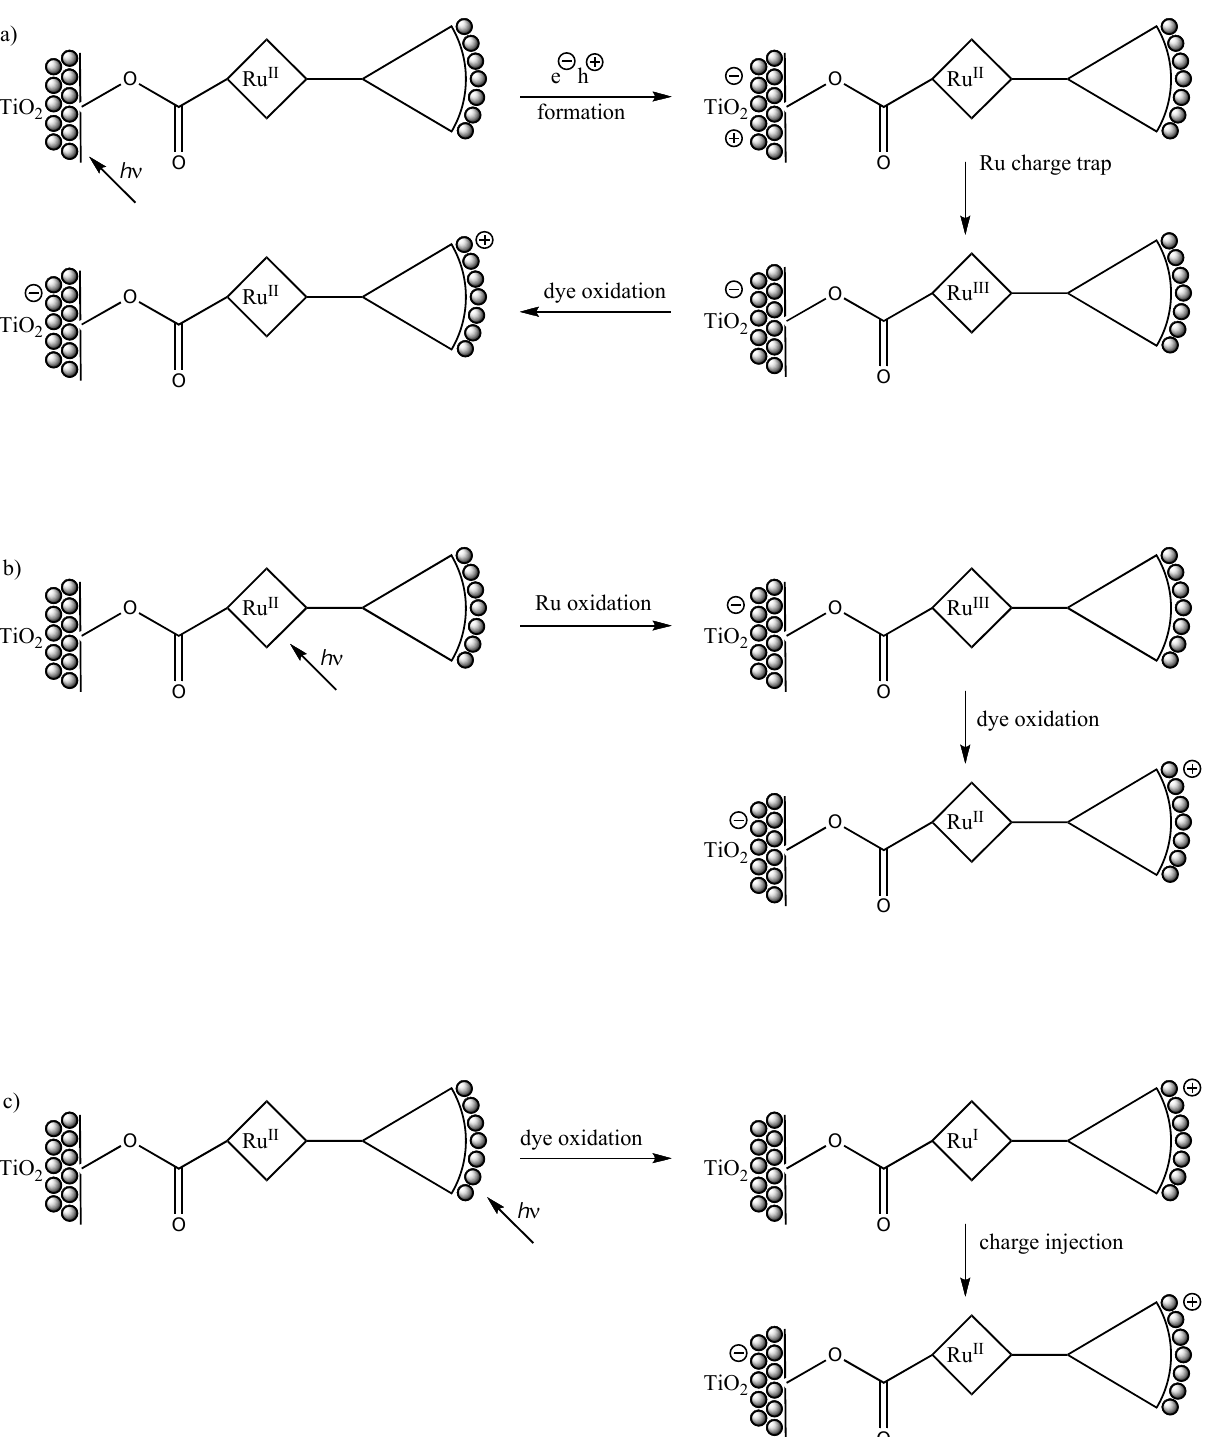
Scheme 2. Possible photoinduced multi-step vectorial charge transfer routes in composite films. Path a: band-gap photocatalysis; path b: MLCT irradiation; dendron/TiO 2 path c: photosensitization by surface-bound